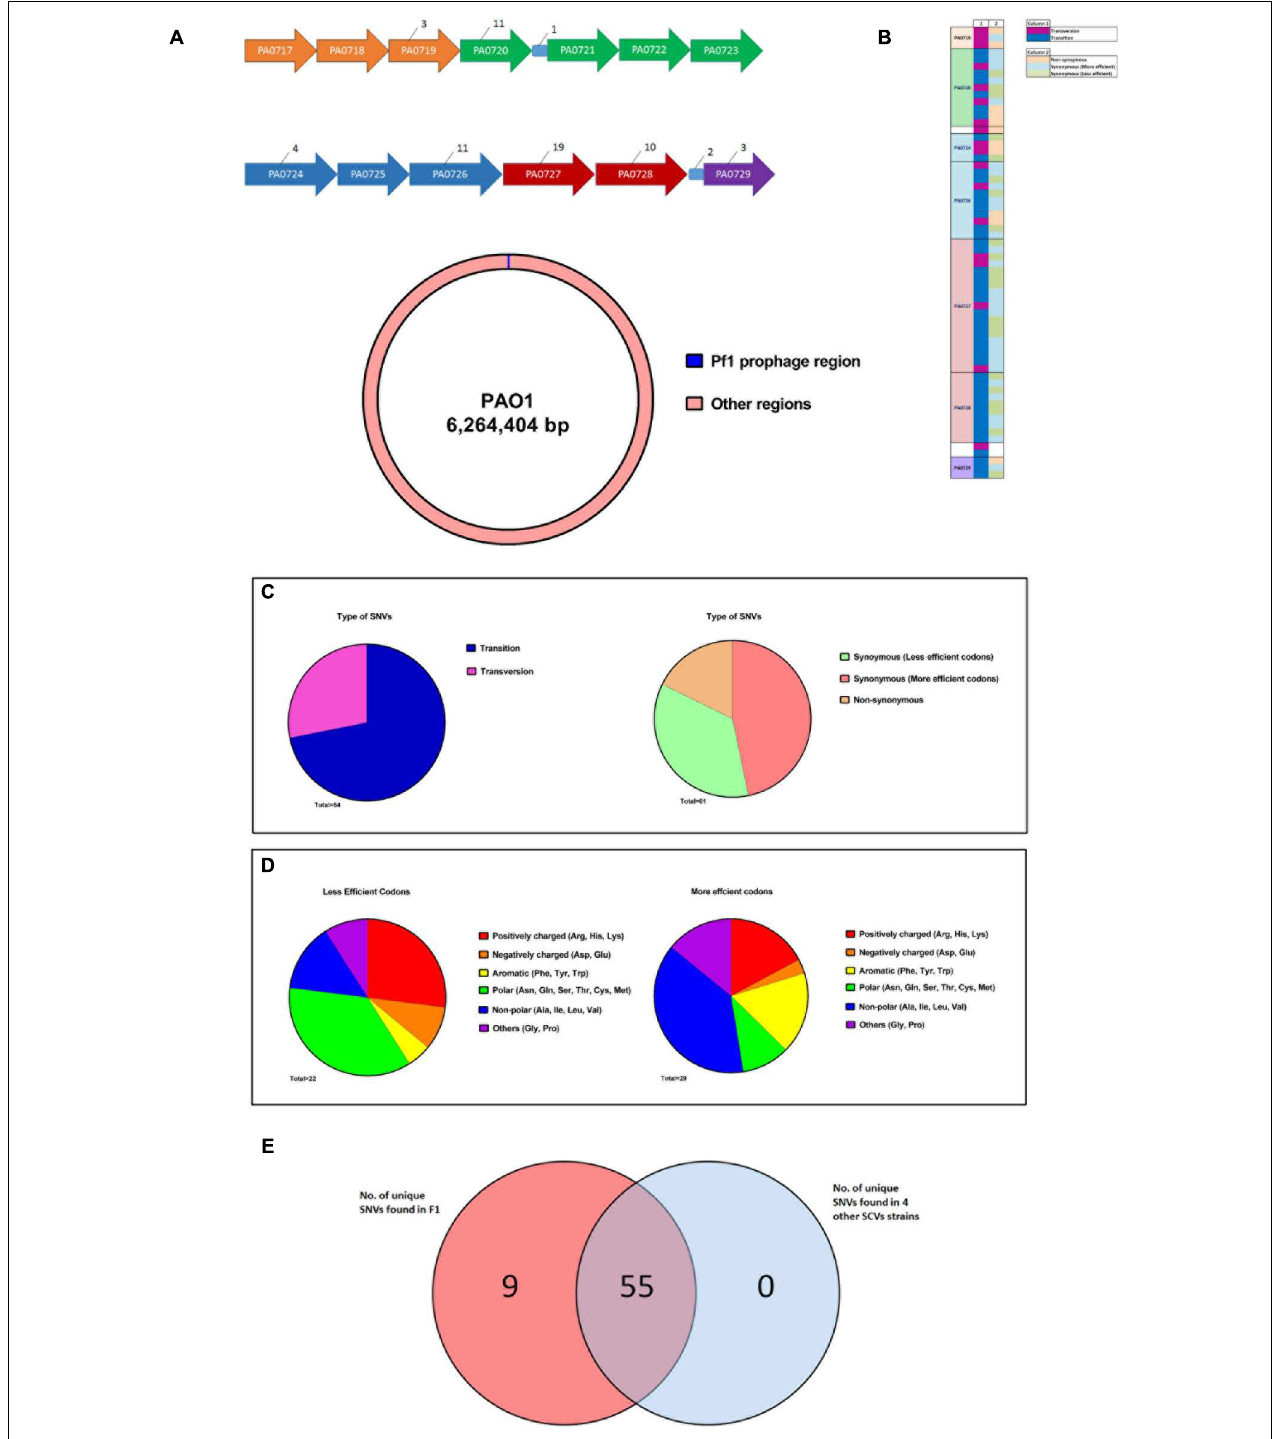
FIGURE 5 | Whole genome sequencing of F1 to identify unique SNVs. (A) Figure showing the distribution of unique F1 strains SNV across the Pf1 prophage regions. All intergenic regions except those containing SNVs were removed for clarity. Numerical values indicate the number of SNVs found in each gene. Genes of the same color belongs to the same operon. (B) A schematic showing the size of Pf1 prophage region ( ∼ 8 kb) in relation the size of the PAO1 genome ( ∼ 6 Mb) (C) Synoymous SNVs were split into two groups based on whether a less or more efficient codon for a particular amino acid was used in F1 and the type of amino acid side chains were shown in the pie charts. Aromatic and branched chain amino acids (yellow and blue regions respectively) were preferentially using a more efficient codon. (D) Diagram showing the attributes of the SNVs found in each locus. (E) Venn diagram showing the distribution of these 64 SNVs across 4 other SNV isolated from F0. 55 of these SNVs are common to all five